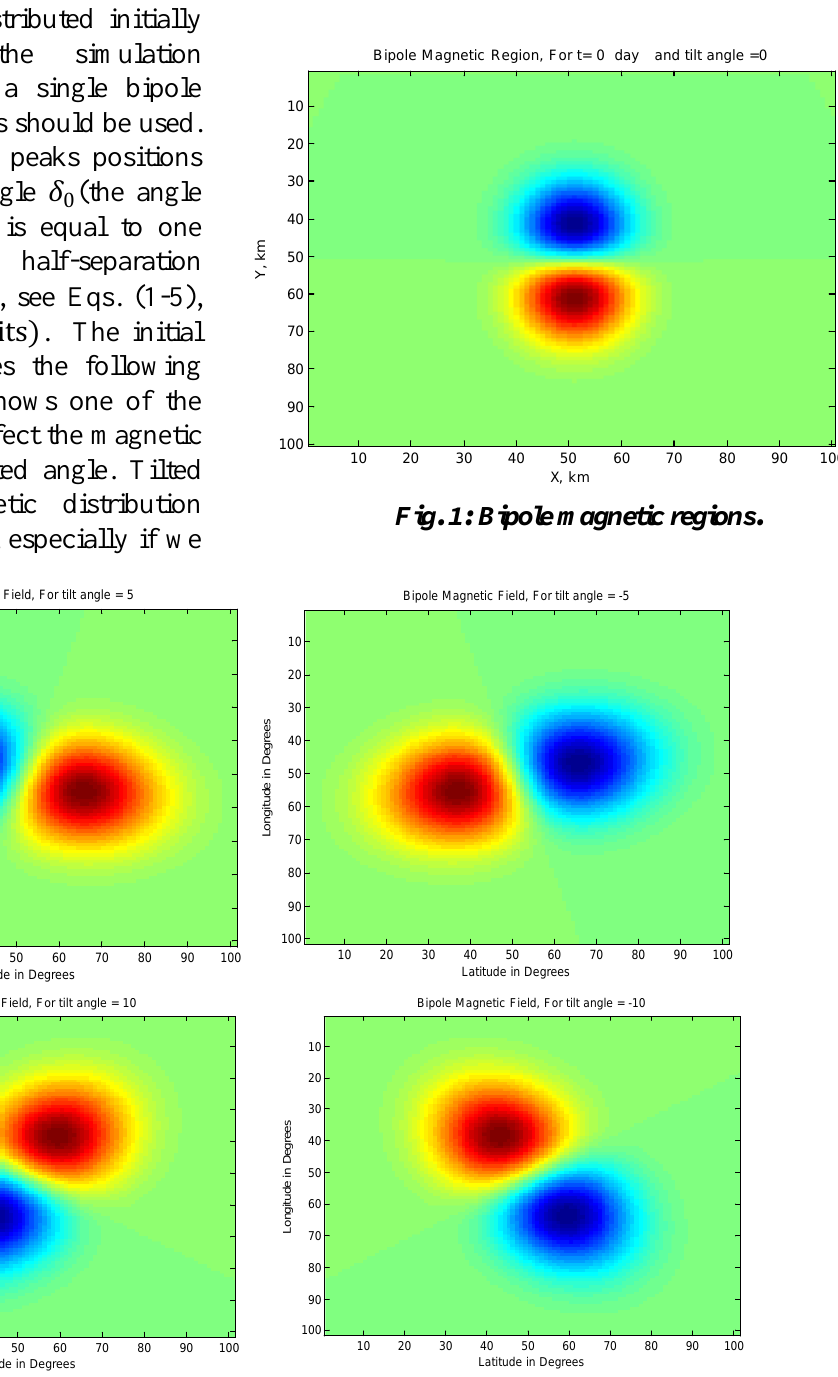
Fig. 2: Simulation the Bipole Magnetic Regions with a positive and negative tilt angles (in